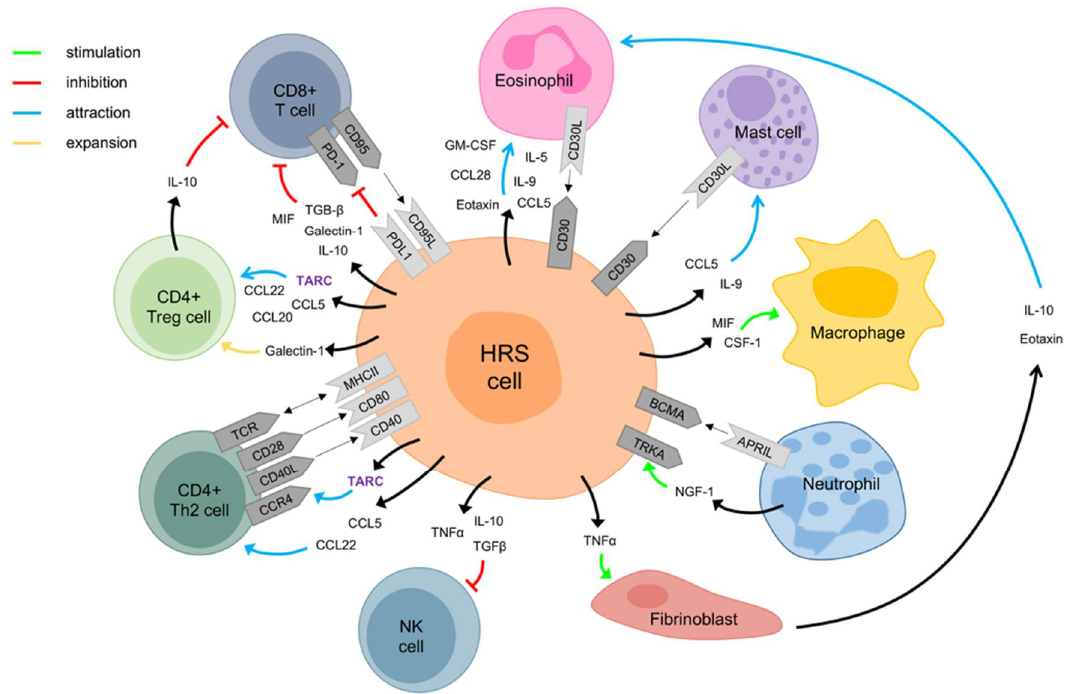
Figure 1. The figure shows interactions between Hodgkin and Reed–Sternberg (HRS) cells and the tumor microenvironment (direct cellular interactions and via soluble mediators). Many different cell types are attracted into the microenvironment by chemo- and cytokines. HRS cells attract CD4+ type 2 T helper (Th2) cells through secretion of the chemokines TARC, CC chemokine 5 (CCL5) and CCL22. These, as well as CCL20, also attract CD4+ regulatory T (Treg) cells. HRS cells are stimulated by neutrophils through APRIL-BCMA interaction and secretion of nerve growth factor-1 (NGF-1). NGF-1 binds to the receptor tyrosine kinase (TRKA) on HRS cells. HRS cells are also stimulated by mast cells and eosinophils by CD30-CD30 ligand interaction. CD8+ T cells, also known as cytotoxic T cells, are inhibited by IL-10, produced by Treg cells. HRS cells also inhibit CD8+ T cells and NK cells through IL-10 and other immunosuppressive mediators and expression of the programmed cell death 1 ligand (PD1L).